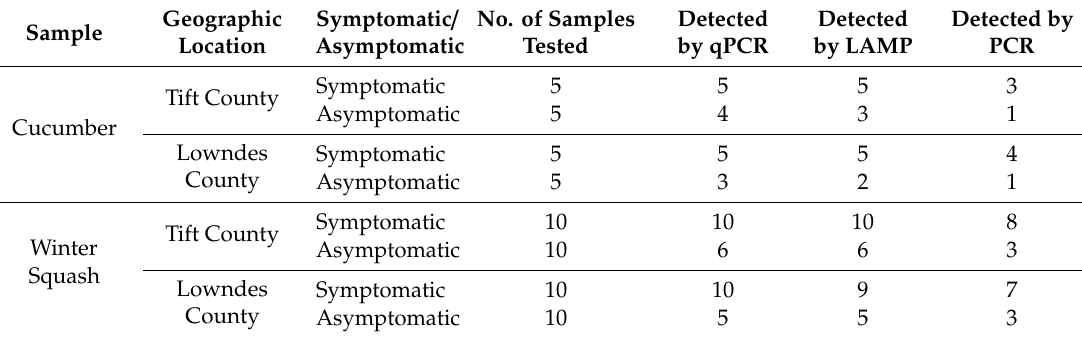
Table 1. LAMP detection of CuLCrV from symptomatic and asymptomatic leaf samples collected from fields in Georgia,